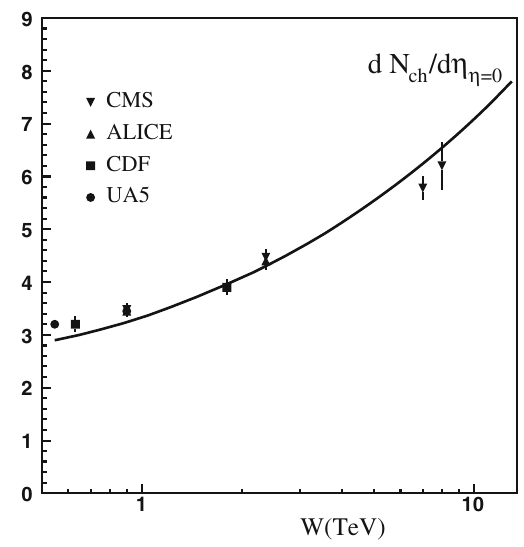
| Fig. 4 d N y = 0 versus energy W. The experimental data are taken d y